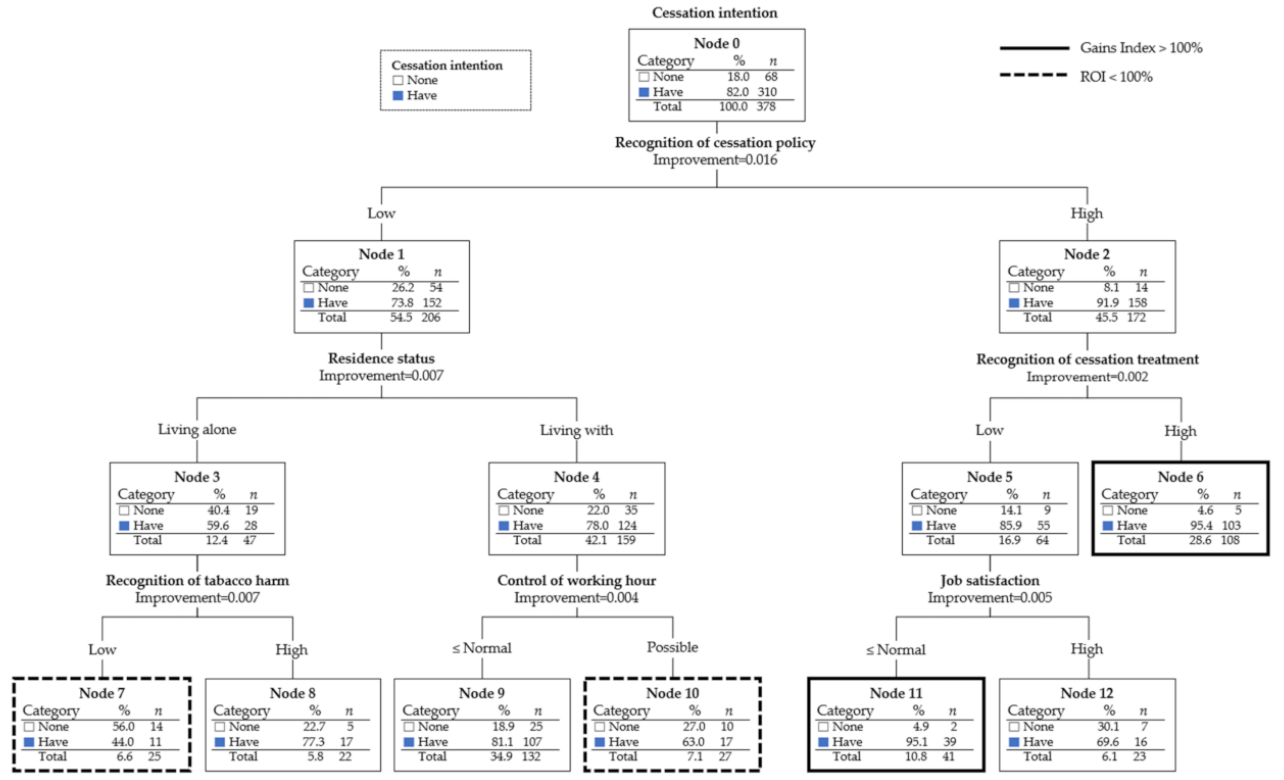
Figure 1. Prediction model of smoking cessation intention of smoking female worker by smoking awareness. Table 3. Gains Index and ROI for Nodes ( n =